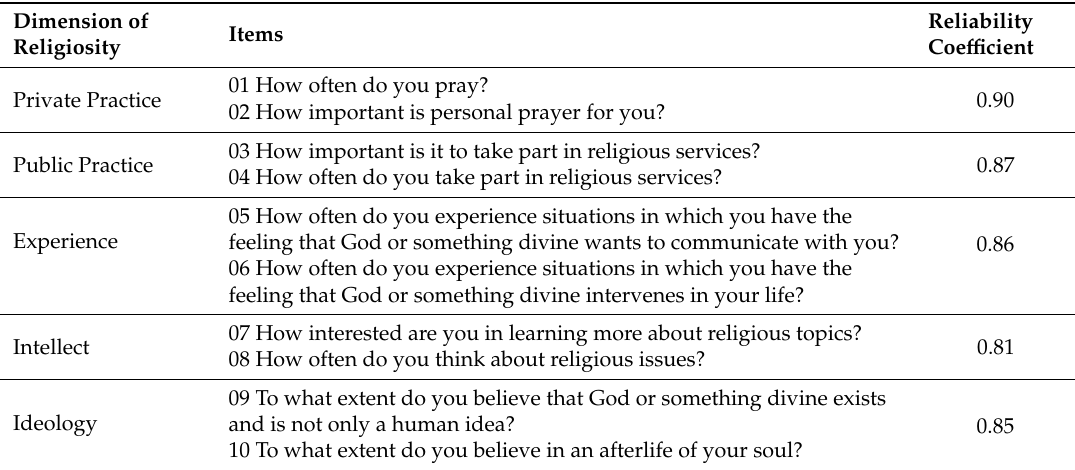
Table 1. Dimensions, items, and reliability of the 10-item Centrality of Religiosity Scale (CRS-10) (by Huber and Huber 2012) for the present sample N =